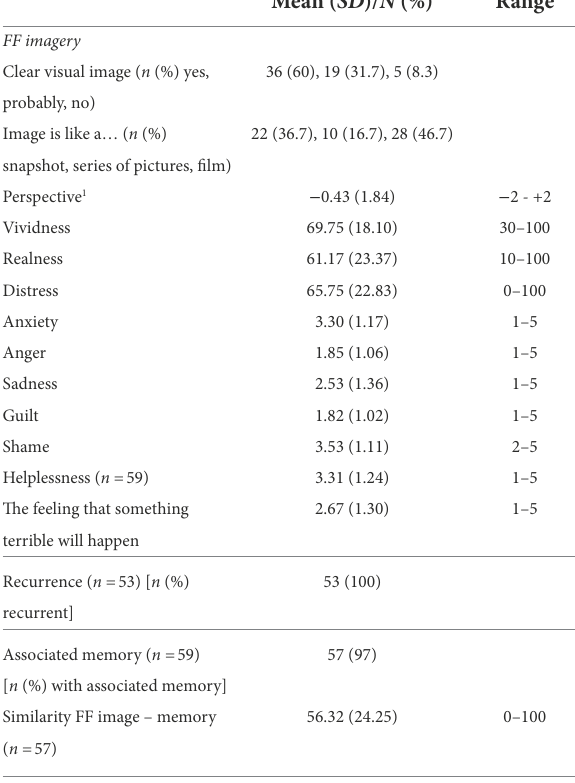
TABLE 3 Flashforward imagery characteristics, recurrence, and similarity to associated